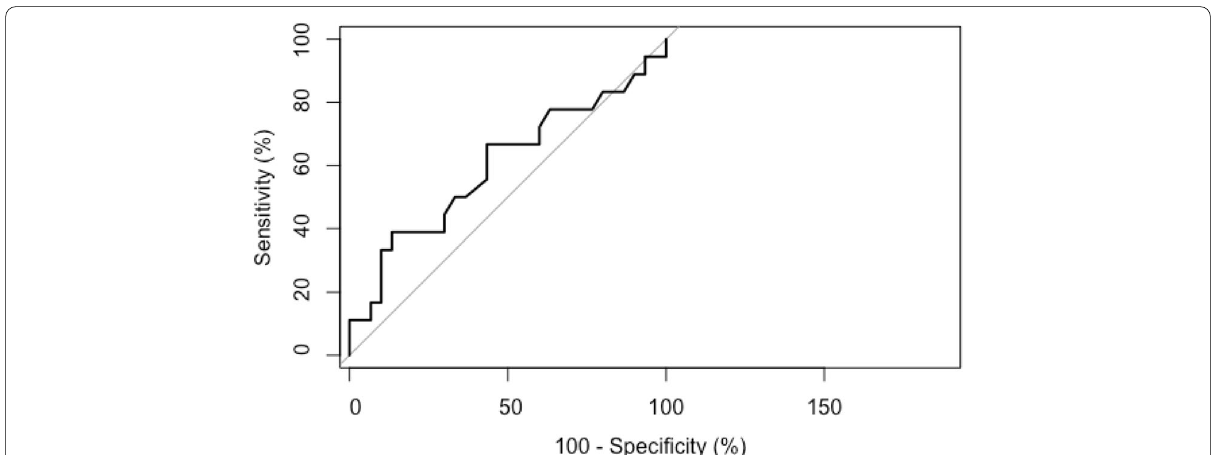
Fig. 3 Relationship between SIRSI specificity and sensibility by ROC